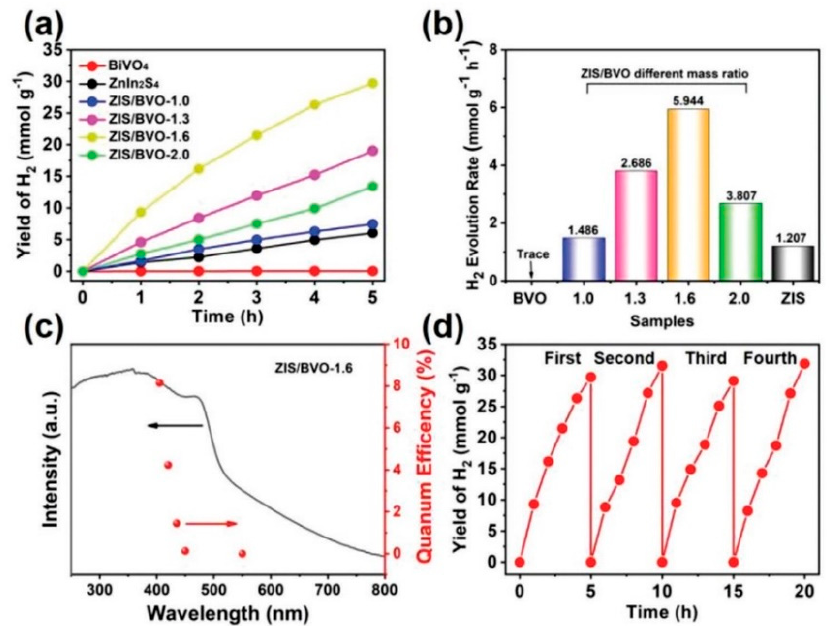
Figure 8. ( a , b ) Photocatalytic H 2 evolution performance of the prepared samples, ( c ) Wavelength dependence of quantum H 2 evolution efficiency of ZIS/BVO-1.6, and ( d ) Multiple cycles of H 2 production over ZIS/BVO-1.6. [Reprinted with permission from reference [35]. Copyright 2020, John Wiley and Sons].